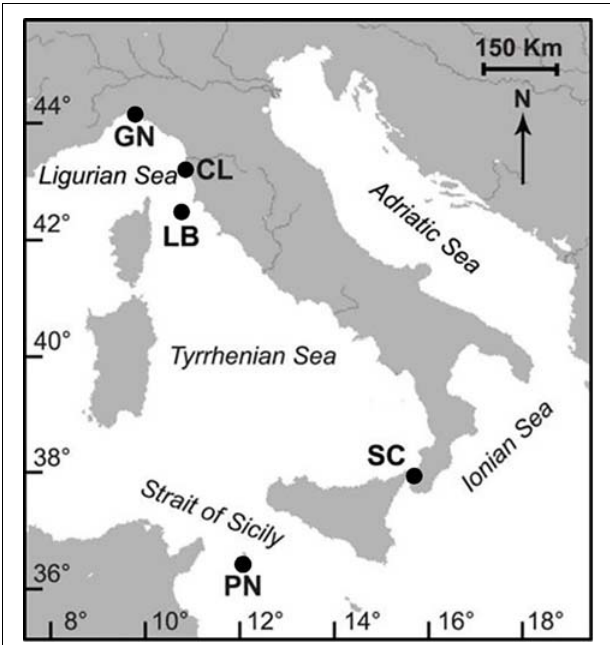
FIGURE 1 | Map of the Italian coastline indicating the sites of coral collection. Abbreviations and coordinates of the sites in decreasing order of latitude: GN Genova, 44 ◦ 20 (cid:48) N, 9 ◦ 08 (cid:48) E; CL Calafuria, 43 ◦ 27 (cid:48) N, 10 ◦ 21 (cid:48) E; LB Elba Island, 42 ◦ 45 (cid:48) N, 10 ◦ 24 (cid:48) E; SC Scilla, 38 ◦ 01 (cid:48) N, 15 ◦ 38 (cid:48) E; PN Pantelleria Island, 36 ◦ 45 (cid:48) N, 11 ◦ 57 (cid:48) E. Map was created by the authors using the